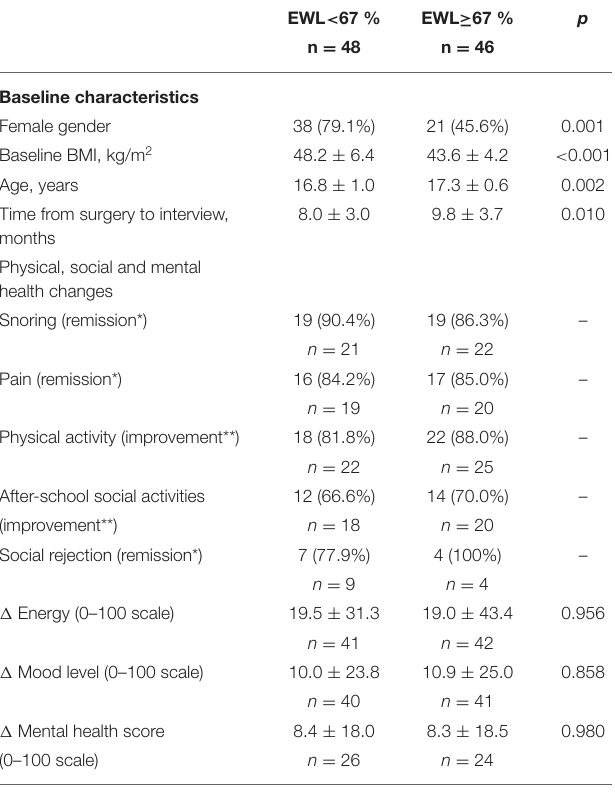
TABLE 3 | Baseline characteristics and quality of life changes post-surgery across percent excess weight loss